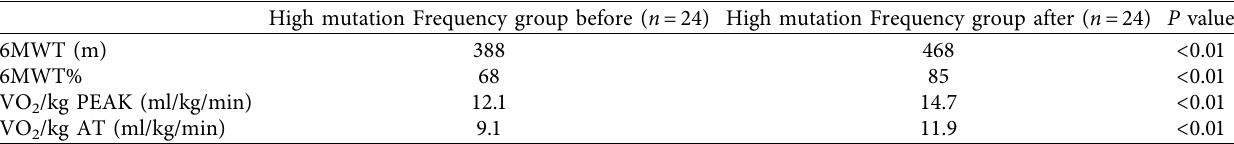
Table 4: Comparison of indices in the high mutation frequency group before and after the 8-week exercise